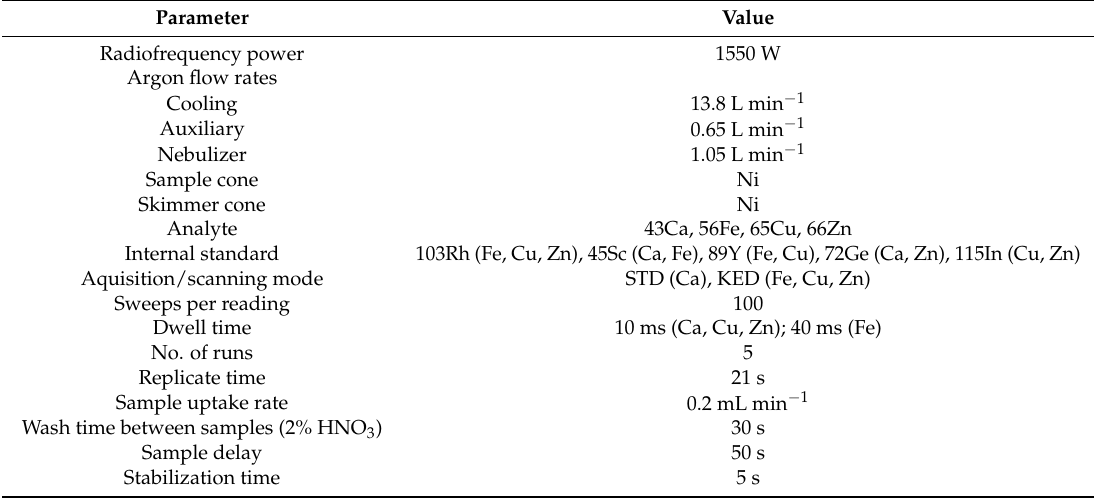
Table 1. ICP-MS operating conditions and measurement parameters.